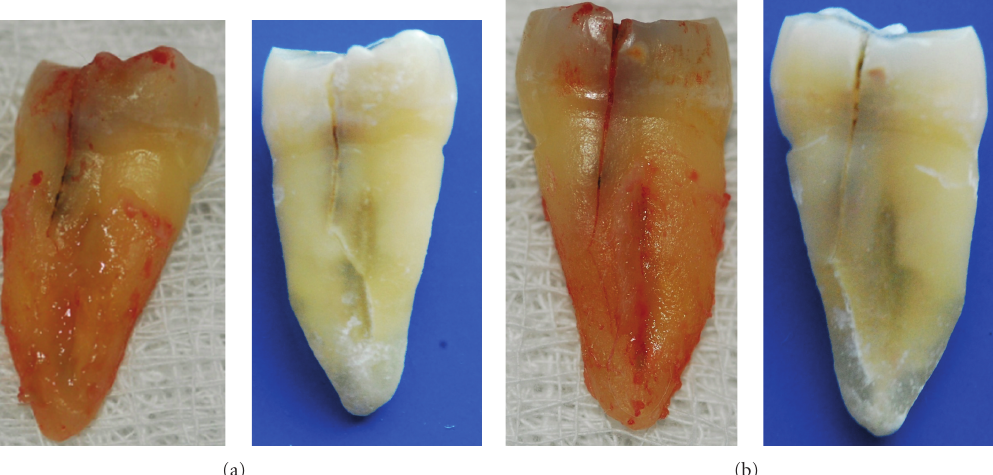
Figure 2: (a) Fracture extending to junction of middle and apical third of root (mesial) of 25. (b) Fracture extending to apical third of root (distal) of 25.